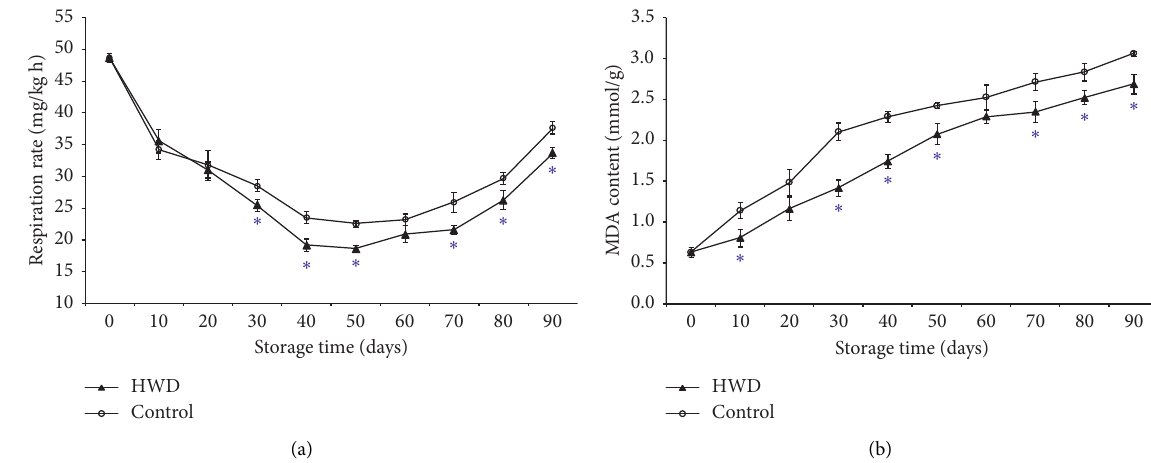
Figure 3: Effect of HWD on respiration rate (a) and MDA content (b) of “Nanfeng” mandarin during 90 days of cold storage at 6 ° C. The symbol ∗ represents significantly lower values for the HWD-treated fruits than the control fruits. The significant difference was determined according to the independent-samples t -test ( P < 0 . 05) on each storage